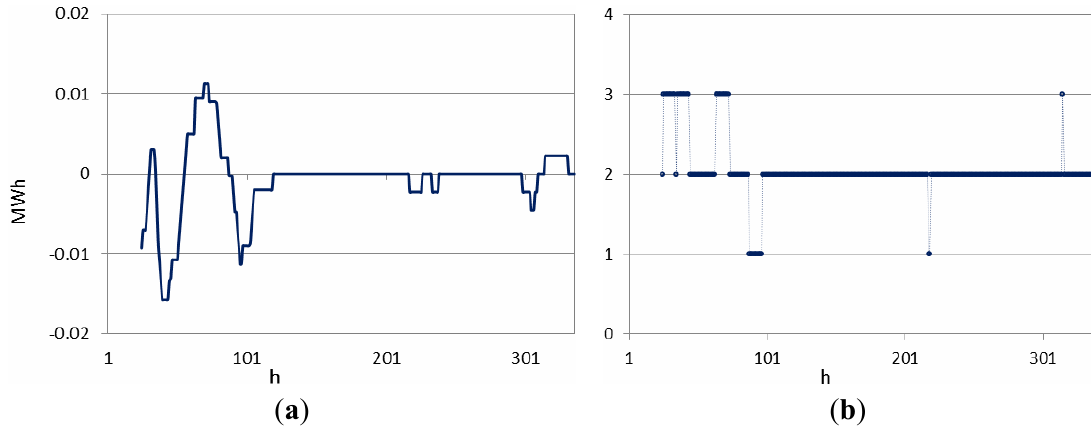
Figure 14. ( a ) Energy stored and released, Δ operations over the battery calculated in each hour within the previous 24